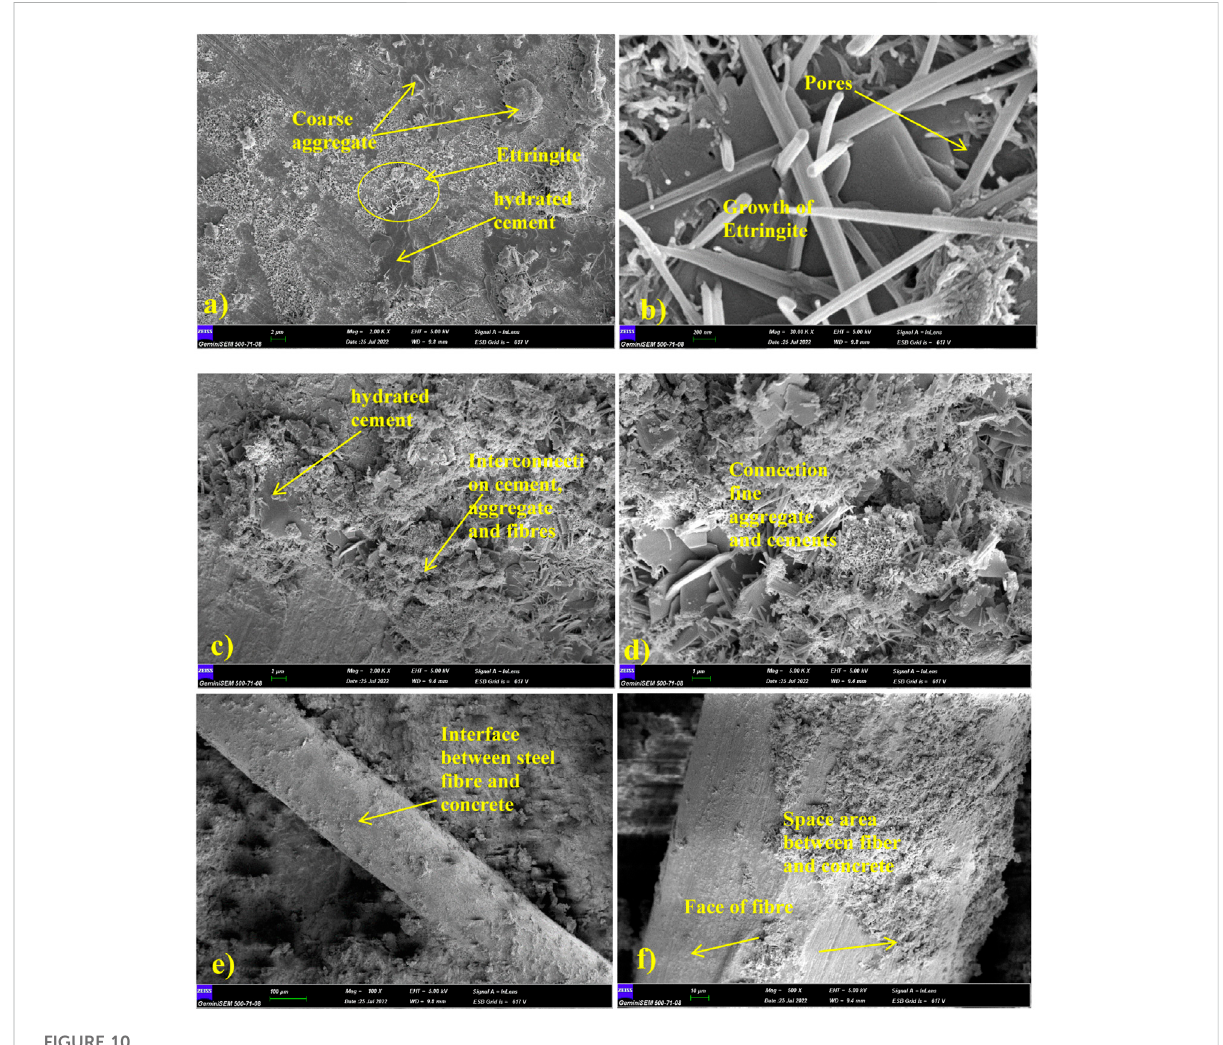
FIGURE 10 Microstructure view of